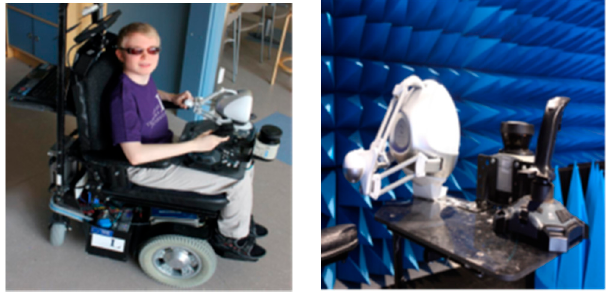
Figure 20. Display the proposed system mounted on the special electronic wheelchair [41].